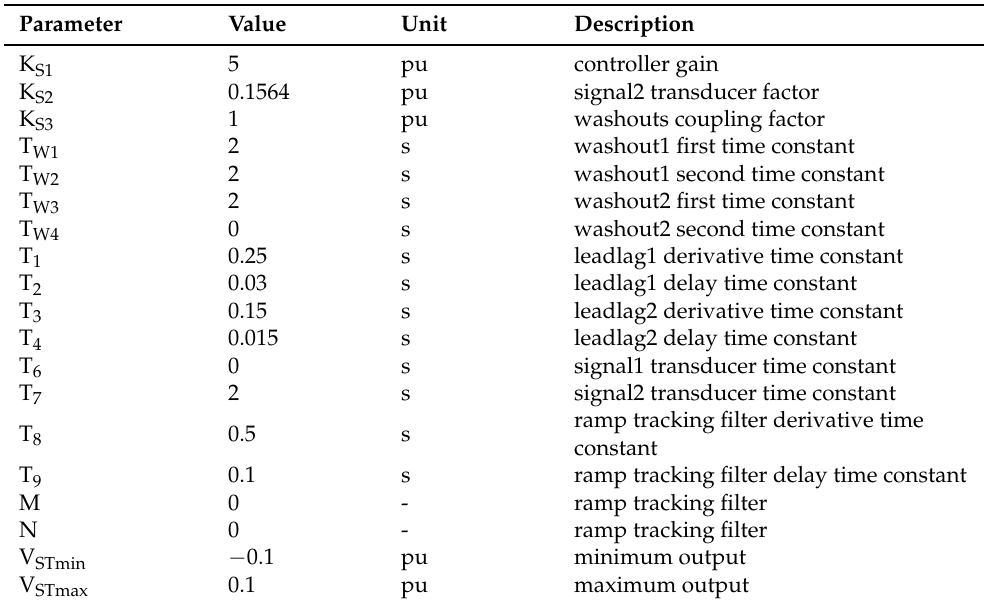
Table A2. Parameters set for the PSS model.